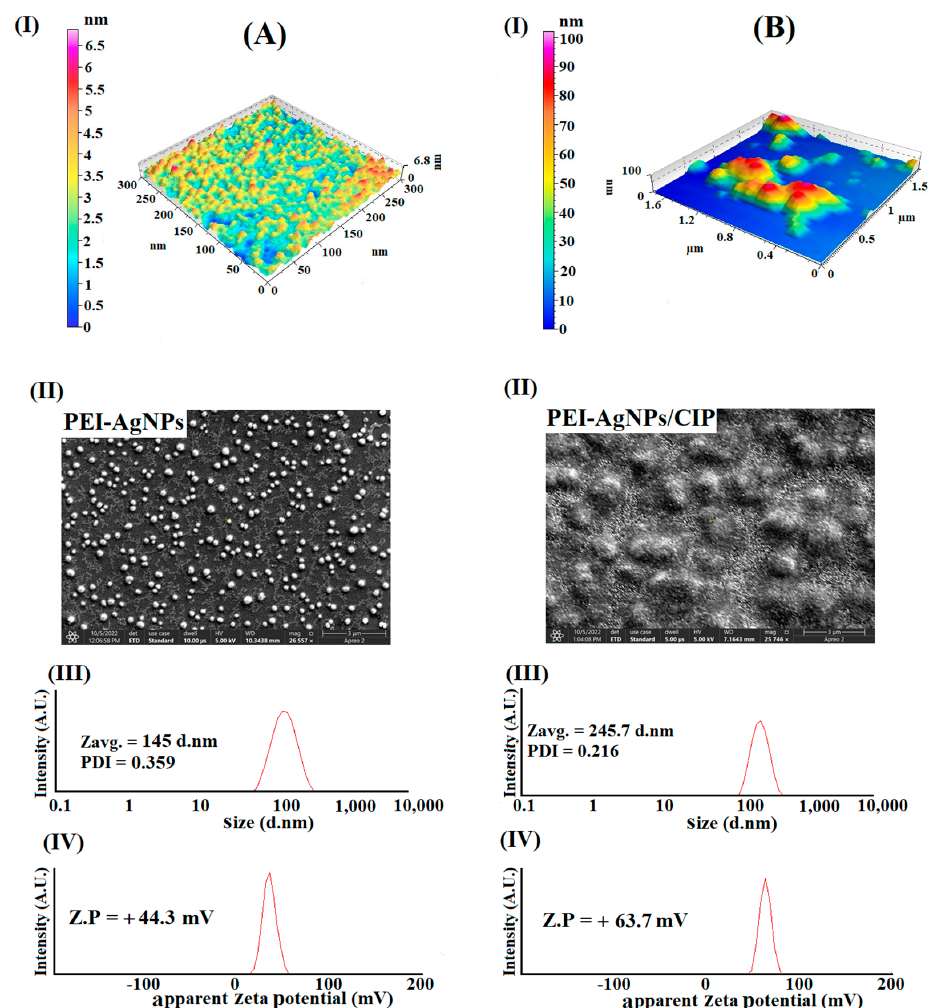
Figure 3. Effect of addition of CIP in PEI-AgNPs. ( A ) PEI-AgNPs (1:15), ( B ) PEI-AgNPs (1:15)/CIP (1.0 mM); ( I ) AFM, ( II ) SEM, ( III ) Average size by zeta sizer, ( IV ) Zeta potential.